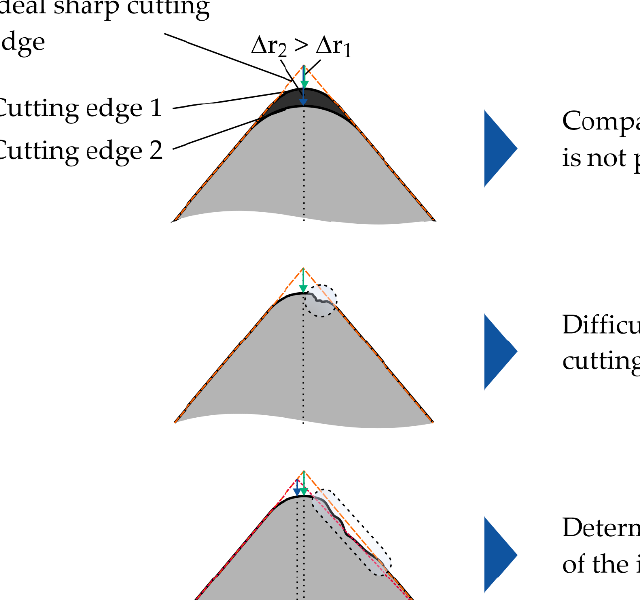
Figure 1. Schematic representation of cutting edge chipping.